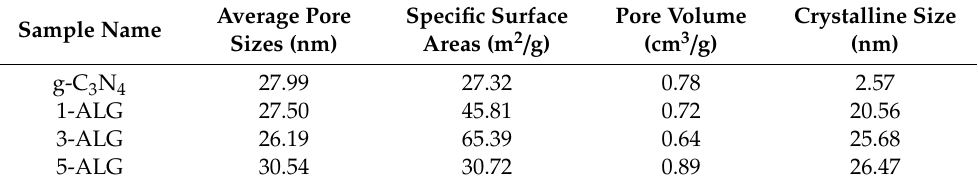
Figure 1. XRD patterns of bare g-C 3 N 4 , AgBr, LaNiO 3 ( a ), 1-ALG, 3-ALG and 5-ALG ( b ). Table 1. The average pore sizes and specific surface areas of g-C 3 N 4 , 1-ALG, 3-ALG and